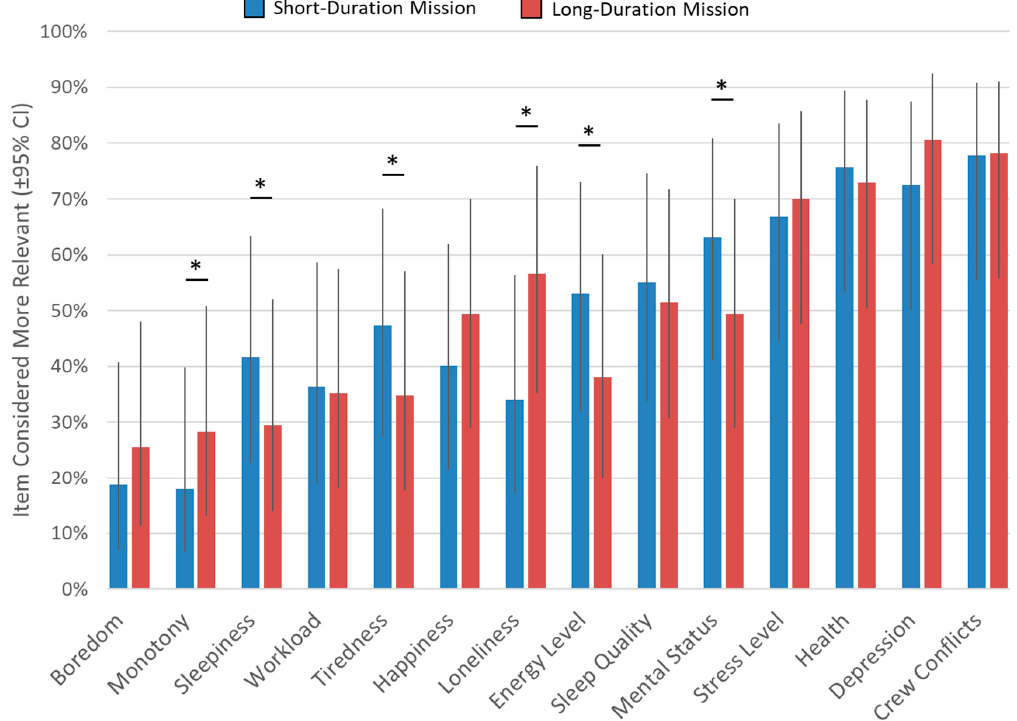
Figure 1. Results of the paired comparison analysis for short- (up to 6 months; blue bars) and long- duration (>6 months; red bars) space missions. Asterisks indicate statistically significant differences at p < 0.05 after adjustment for multiple testing (N = 14) between short- and long-duration missions for the proportion in which each of the items was considered more relevant. Items are sorted in ascending order from left to right based on the average proportion of short- and long-duration ratings. Error bars reflect 95% confidence intervals (CI).